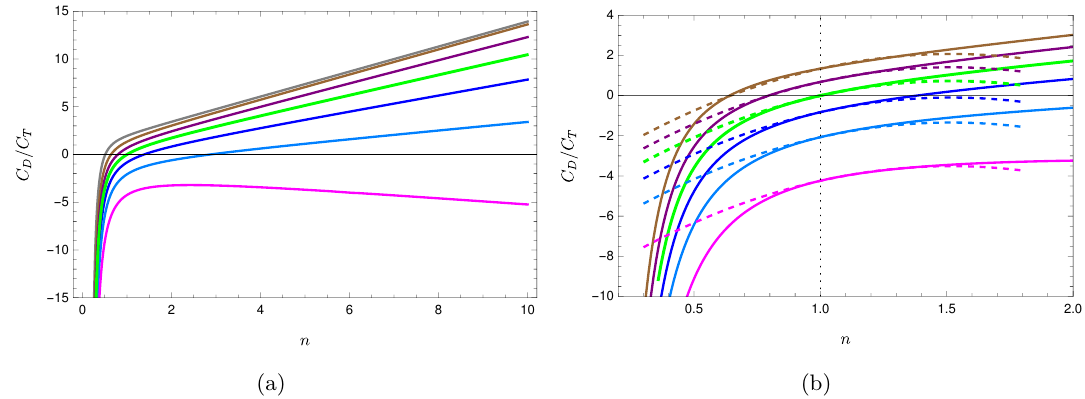
Figure 8 . Plots of C D /C T , defined in eqs. (3.13) and (3.35), as a function of n in d = 6 . The colours correspond to different fixed values of the chemical potential ˜ µ in eq. (3.37) with ‘ (a) The different curves correspond to ˜ µ 2 = ± 0 . 04 , ± 0 . 09 , ± 0 . 16 , with ˜ µ 2 increasing from top to bottom. We highlight in green the curve corresponding to ˜ µ = 0 . Note that ˜ µ 2 can be negative, as the chemical potential can take imaginary values. (b) Zoom of the same plot around the region close to n = 1 . The dashed lines correspond to the analytic expansions in eq. (D.10). Curves with the same colours correspond to the same chemical